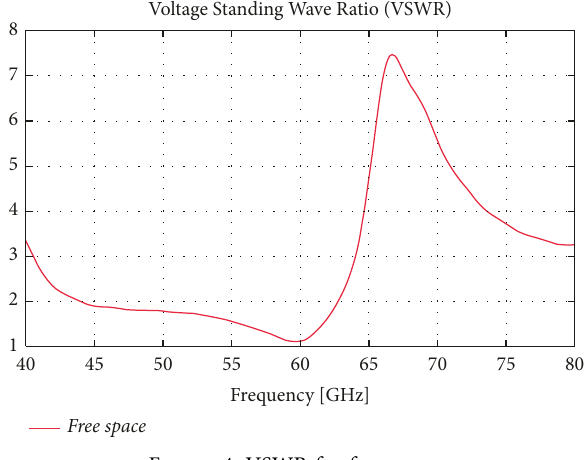
Figure 4: VSWR for free space.